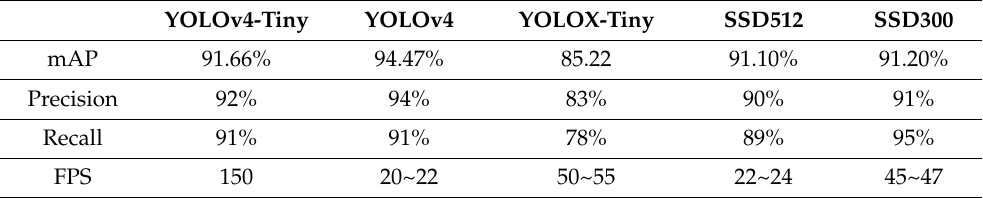
Table 18. Comparisons of the top-view training results among different neural models.